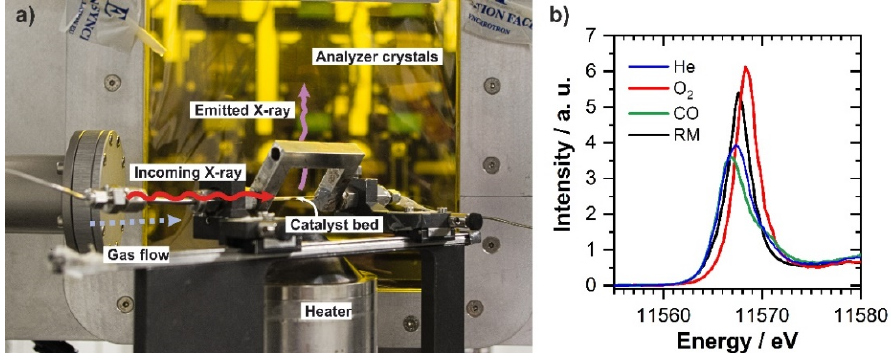
Figure 3. ( a ) Schematics of the operando HERFD-XAS setup at BM16 (ESRF, Grenoble). ( b ) In situ Pt L III -edge HERFD-XANES spectra recorded at room temperature in different gas atmospheres: 10% O 2 /He (red), He after temperature programmed oxidation (blue), 1000 ppm CO/He (green) and reaction mixture (RM, 1000 ppm CO, 10% O 2 in He, black).